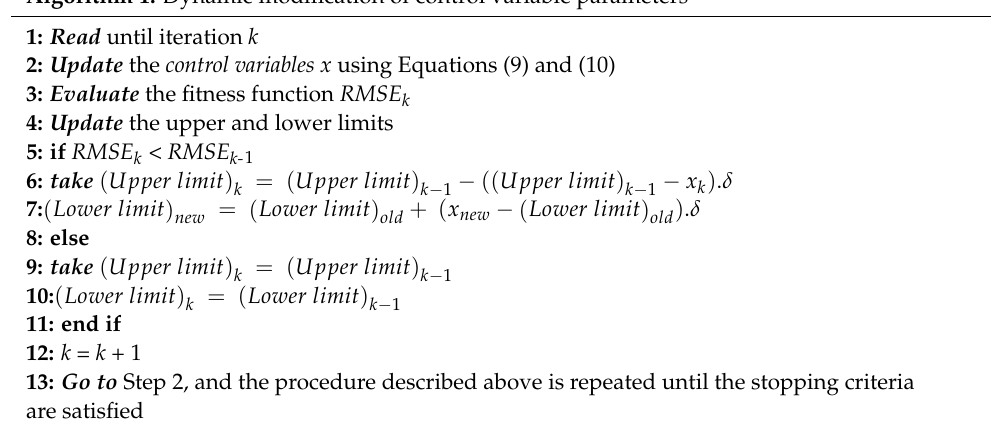
Algorithm 1. Dynamic modification of control variable